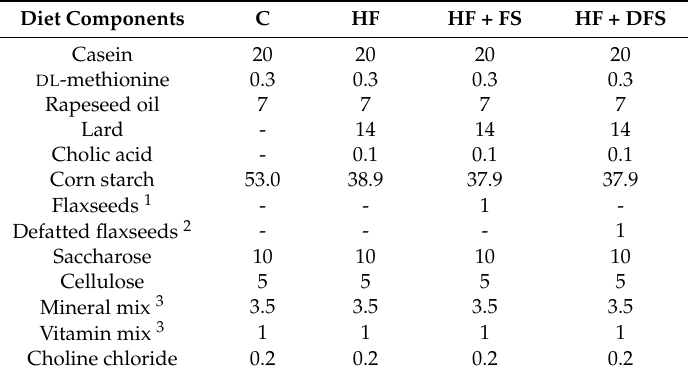
Table 1. Composition of diets fed to rats (%).